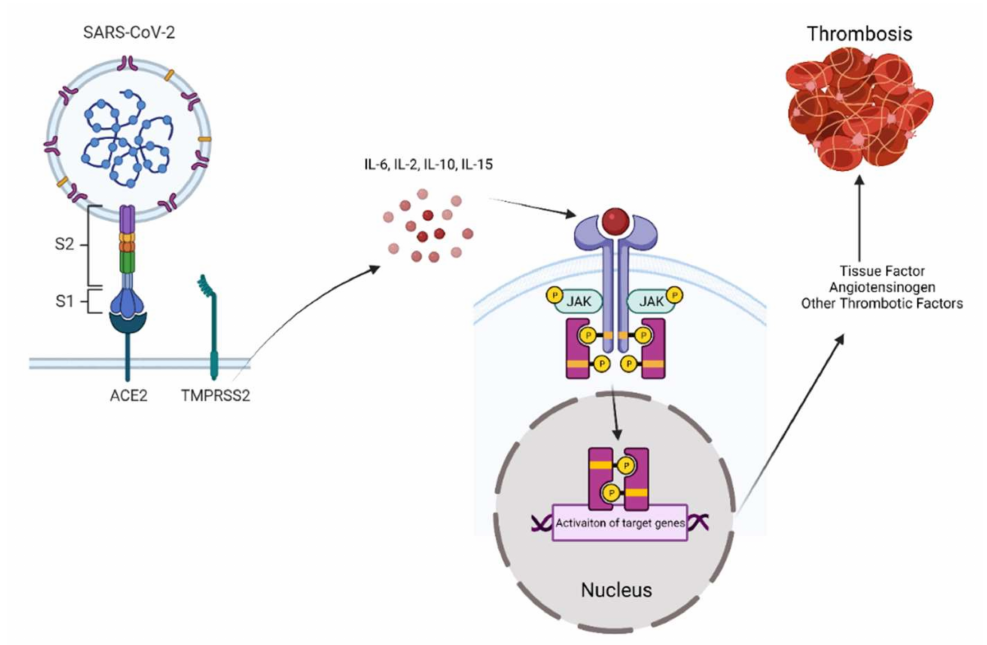
Figure 1. Schematic illustration of SARS-CoV-2-induced JAK–STAT activation and thrombosis. A cytokine storm associated with SARS-CoV-2 infection activates JAK–STAT signaling in target cells, including endothelial and inflammatory cells. In turn, activated JAK–STAT upregulates tissue factors and other thrombotic factors such as von Willebrand factor (vWF) to trigger an extrinsic coagulation cascade, contributing to wide spread macro and microvascular